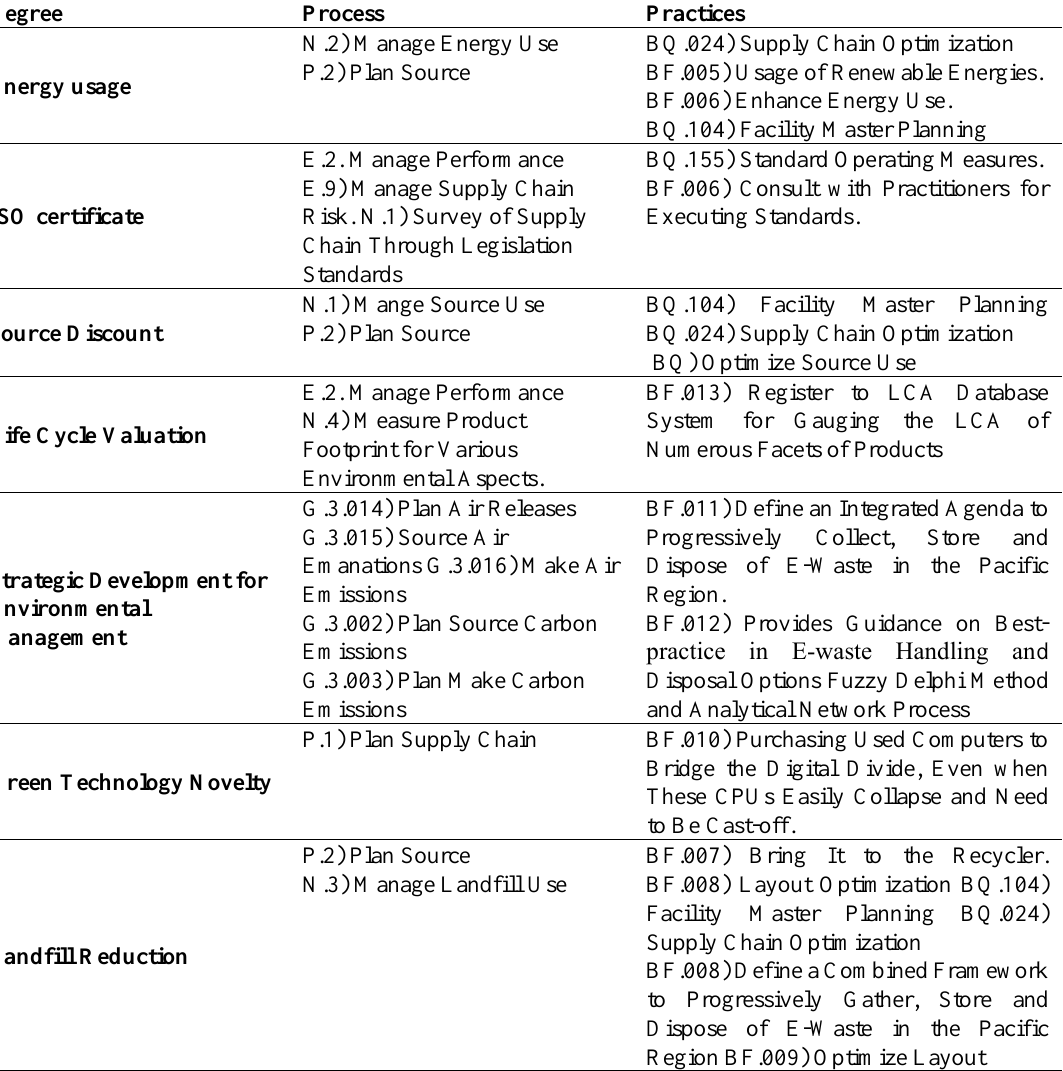
Table.4. The Connection between the New Green Supply Chain Operations Reference Measures with the Process and Features of Supply Chain